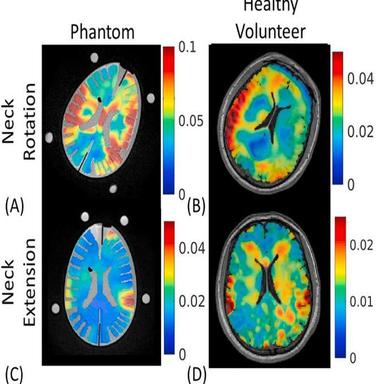
This figure shows the largest value of maximum principal strain (MPS) over the first 150 ms at each voxel during neck rotation in the (A) phantom and (B) a healthy volunteer, and during neck extension in the (C) phantom and (D) a healthy volunteer.